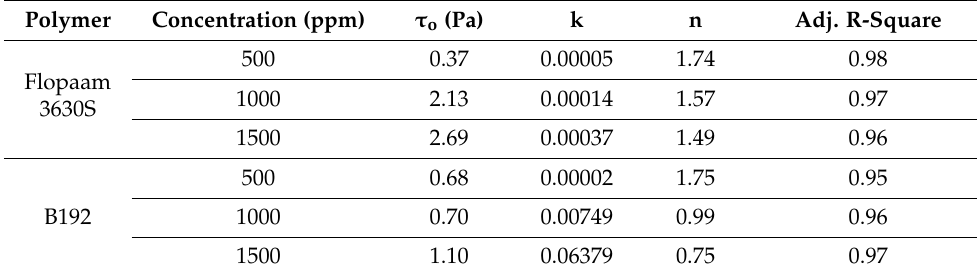
Table 2. Parameter values of samples using Herschel—Bulkley